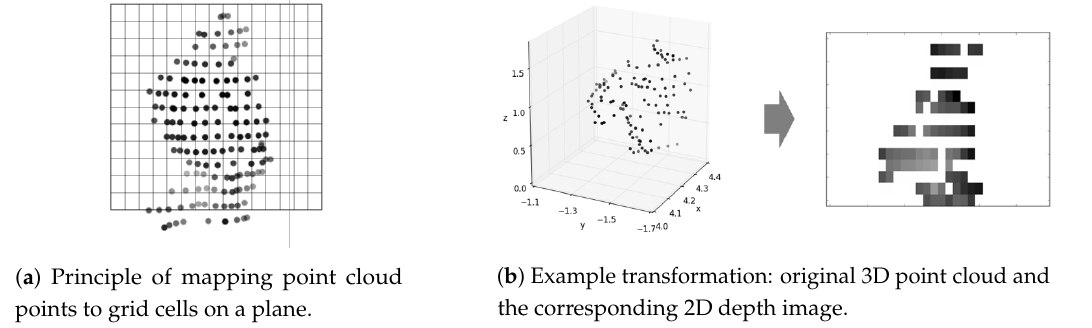
Figure 5. Transformation of LiDAR point cloud into a 2D depth